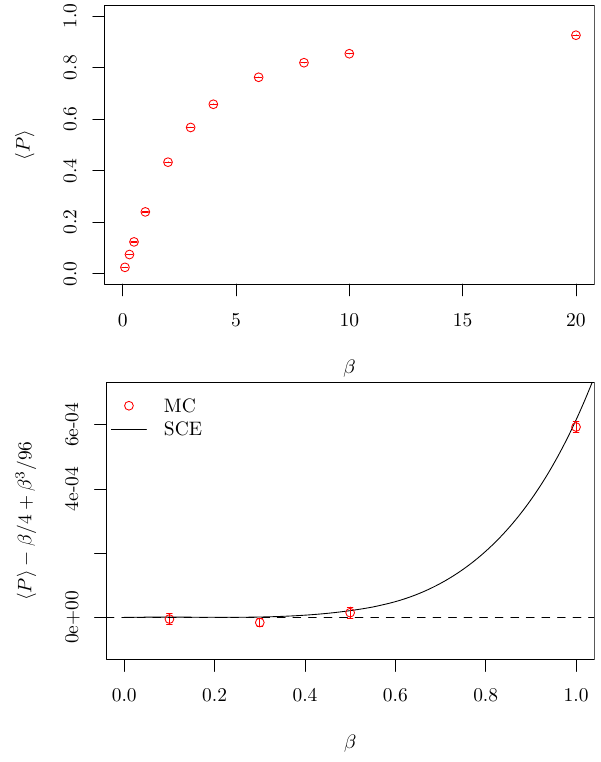
Fig. 2 Plaquette expectation value as a function of β in 1 + 1 dimen- sions. In the lower panel we compare to the strong coupling expansion (SCE) Eq. (29)